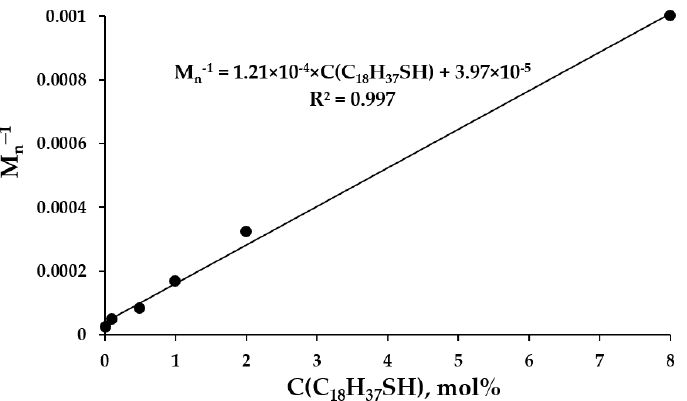
Figure 2. Dependence of the number average molecular weight PVP-OD on the concentration of n- octadecyl mercaptan in coordinates 𝑀̅ 𝑛−1 vs. 𝐶(C 18 H 37 SH) . n-octadecyl mercaptan in coordinates M − 1